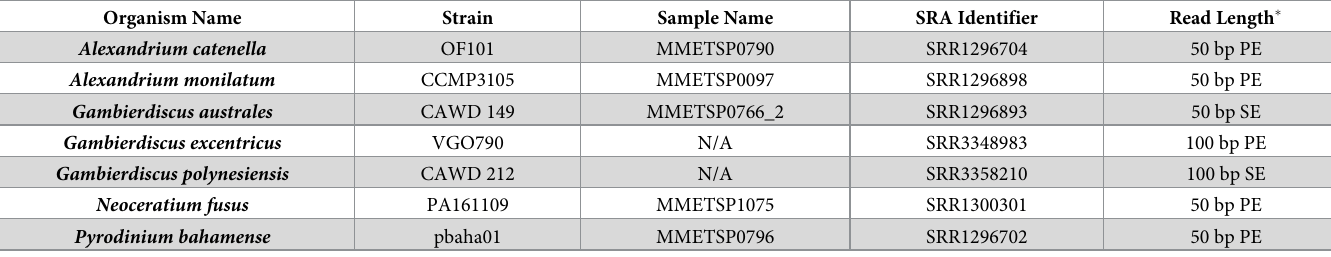
Table 2. Publicly available transcriptomes used in this phylogenetic